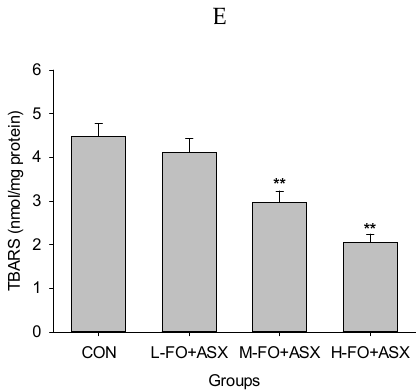
Figure 6. Effects of FO and ASX on SOD ( A ), GPx ( B ) and CAT activity ( C ), GSH ( D ), and TBARS ( E ) in liver of rats fed a high-fat diet. CON: high-fat diet group; L-, M- and H-FO + ASX: low, moderate, and high FO and ASX groups. Bars represent means ± SEM ( n = 10 animals/group). * p < 0.05 and ** p < 0.01 compared to CON group.